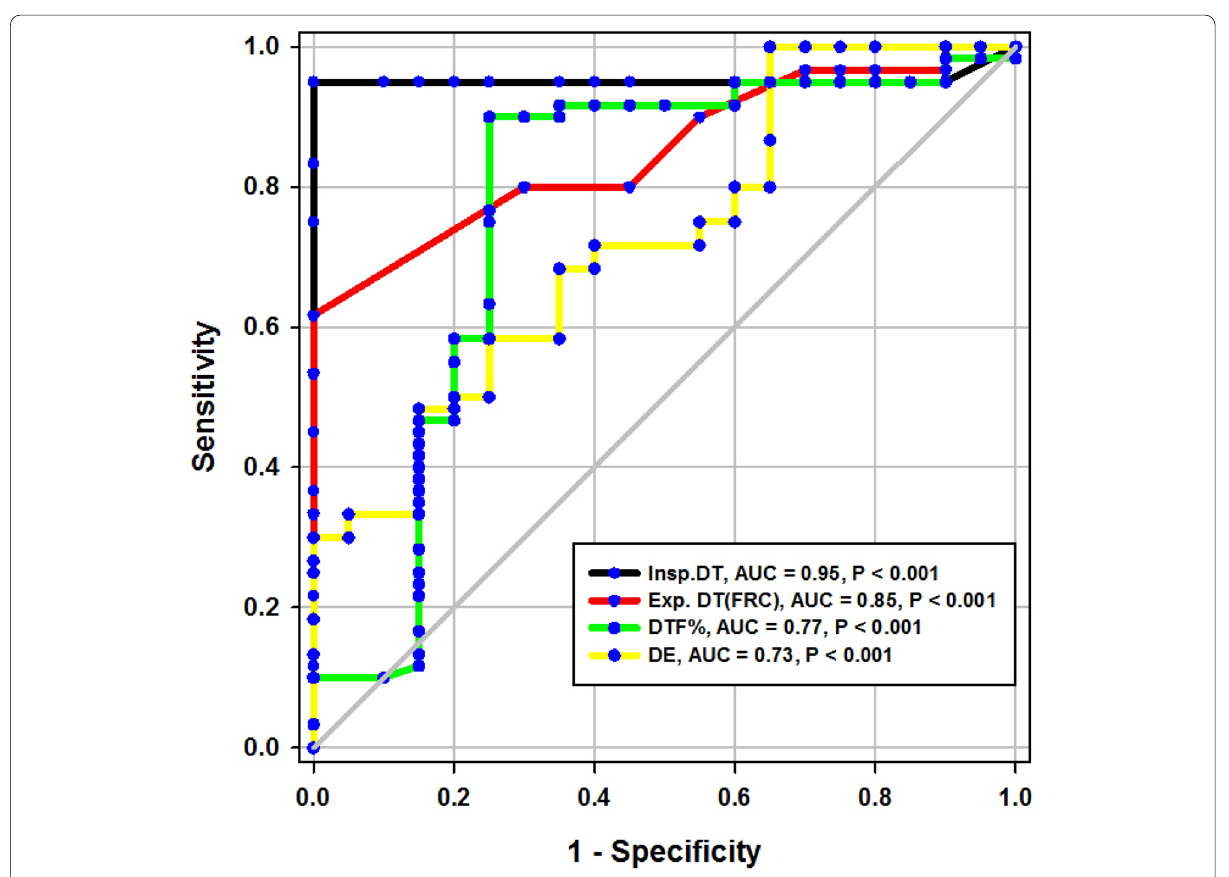
Fig. 3 ROC curve of diaphragmatic parameters during tidal